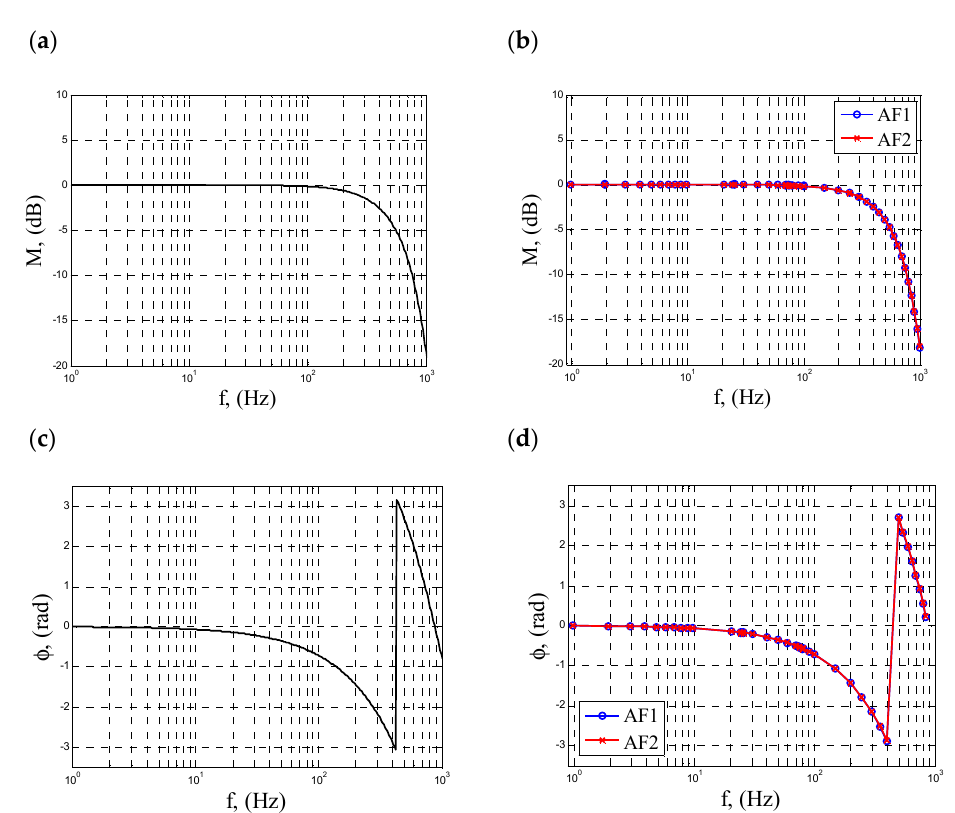
Figure 3. Frequency characteristics of the amplitude ( a , b ) and phases ( c , d ) of analog filters used in voltage measuring paths (AF1) and in the stator current measuring paths (AF2) of the roadheader’s cutterhead driving motor; ( a , c ) theoretical characteristics, ( b , d ) empirical characteristics.